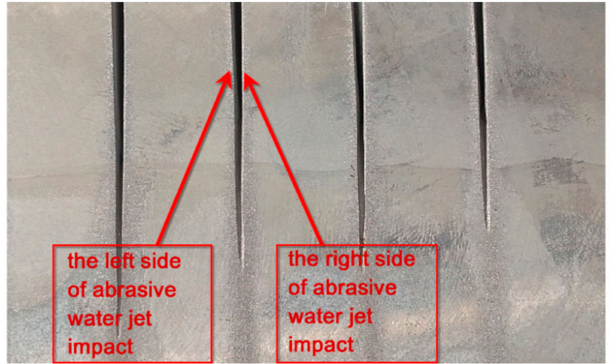
Figure 6. Effect of water jet action, the creation of “jet impact